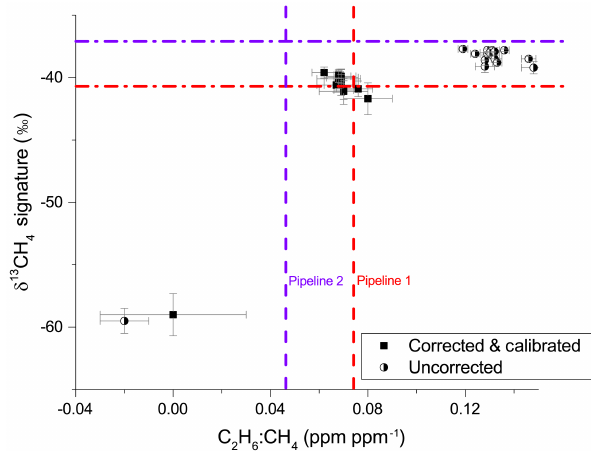
Figure 11. Distribution of 16 events according to their C 2 H 6 :CH 4 ratios and isotopic signature. The red and purple dashed lines sig- nify the characterizations of Pipeline 1 and 2 respectively as mea- sured by the CRDS instrument from flask samples taken on the 4 July 14. For corrected and calibrated data (square markers), both the isotopic signature and C 2 H 6 :CH 4 ratios identify the biogenic source (bottom-left point) and suggest the natural gas emissions em- anate from Pipeline 1. Circular markers represent the uncorrected data which does not agree with the flask sample measurements of pipelines 1 or 2. The error bars indicate the standard error of the slope calculated from Miller–Tans and C 2 H 6 vs. CH 4 plots for δ 13 CH 4 signature and C 2 H 6 :CH 4 ratio respectively.